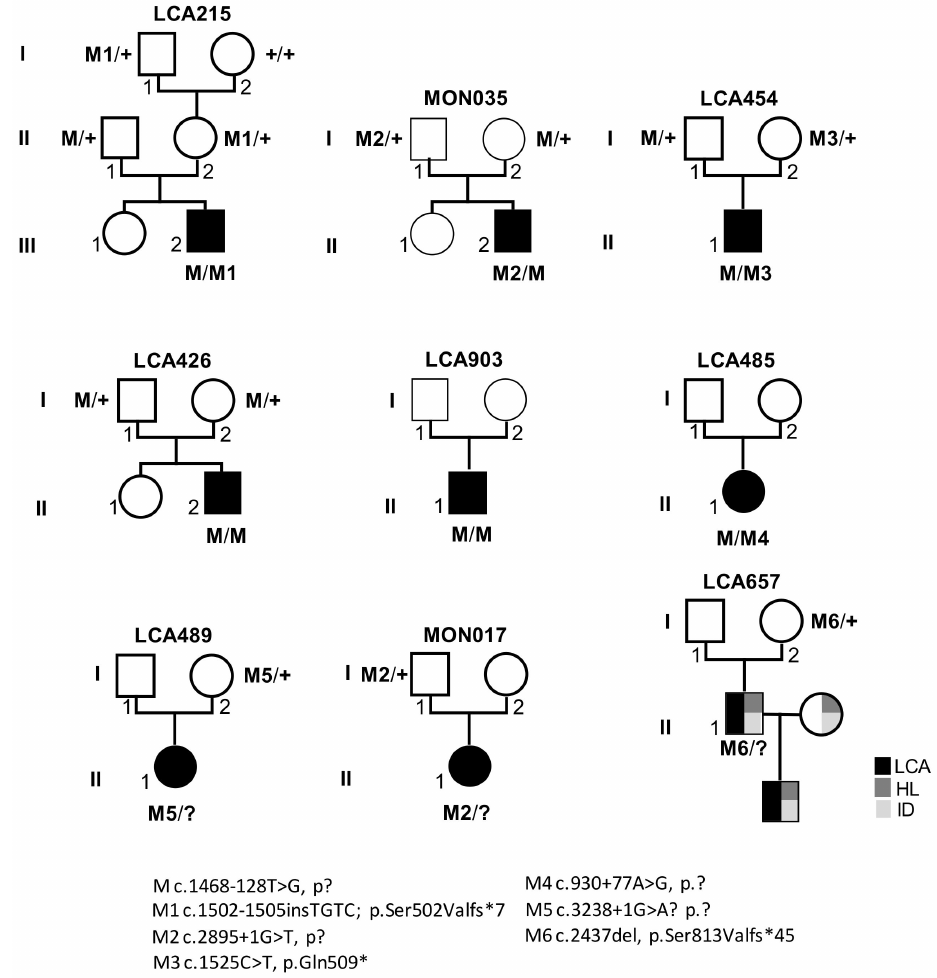
Figure 1. Pedigrees of LCA families and segregation analysis of RPGRIP1 pathologic variants. M: c.1468-128T>G; p.?, M1 c.1502-1505insTGTC; p.Ser502Valfs*7, M2 c.2895+1G>T, p?, M3